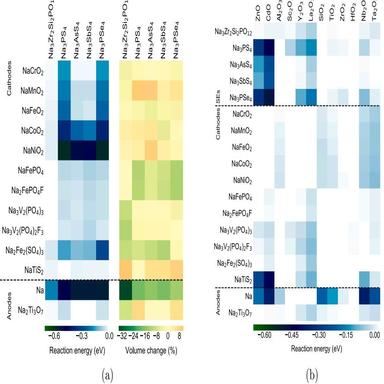
Reaction energies and volume changes for (a) discharged electrode/solid electrolyte pairs and (b) potential buffer layer materials and active materials, in allsolid-state sodium-ion batteries. Reproduced with permission from Ref. .